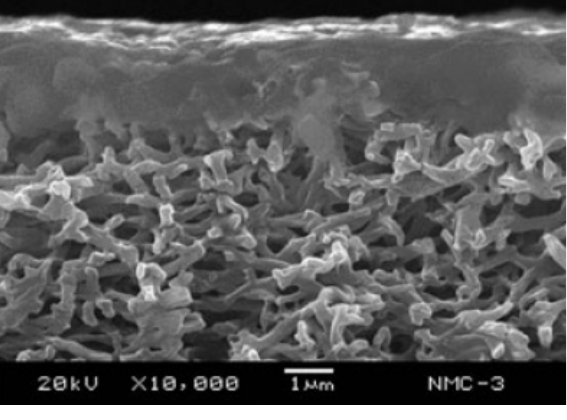
Figure 7. Scanning electron microscope image of nylon-6 membrane after sequential polymerization of a Am-AA IPN